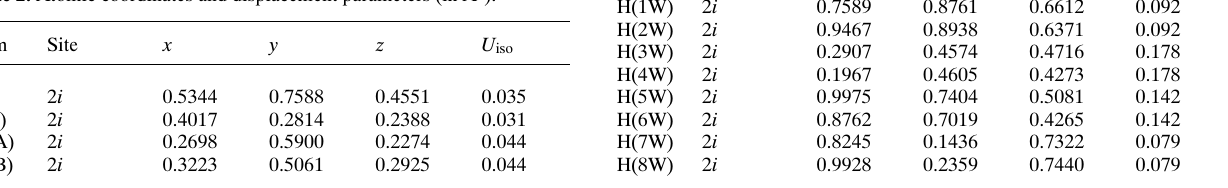
Table 2. Atomic coordinates and displacement parameters (in Å 2 )